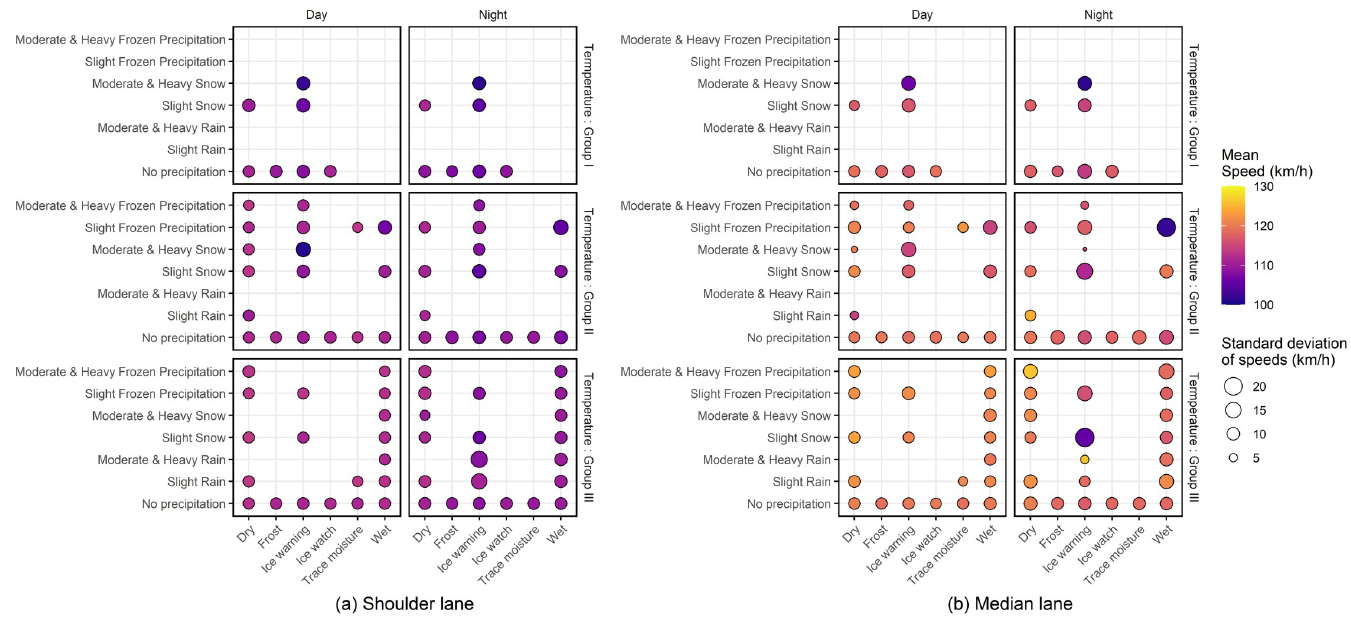
Fig 3. Distribution of speeds in the study site.